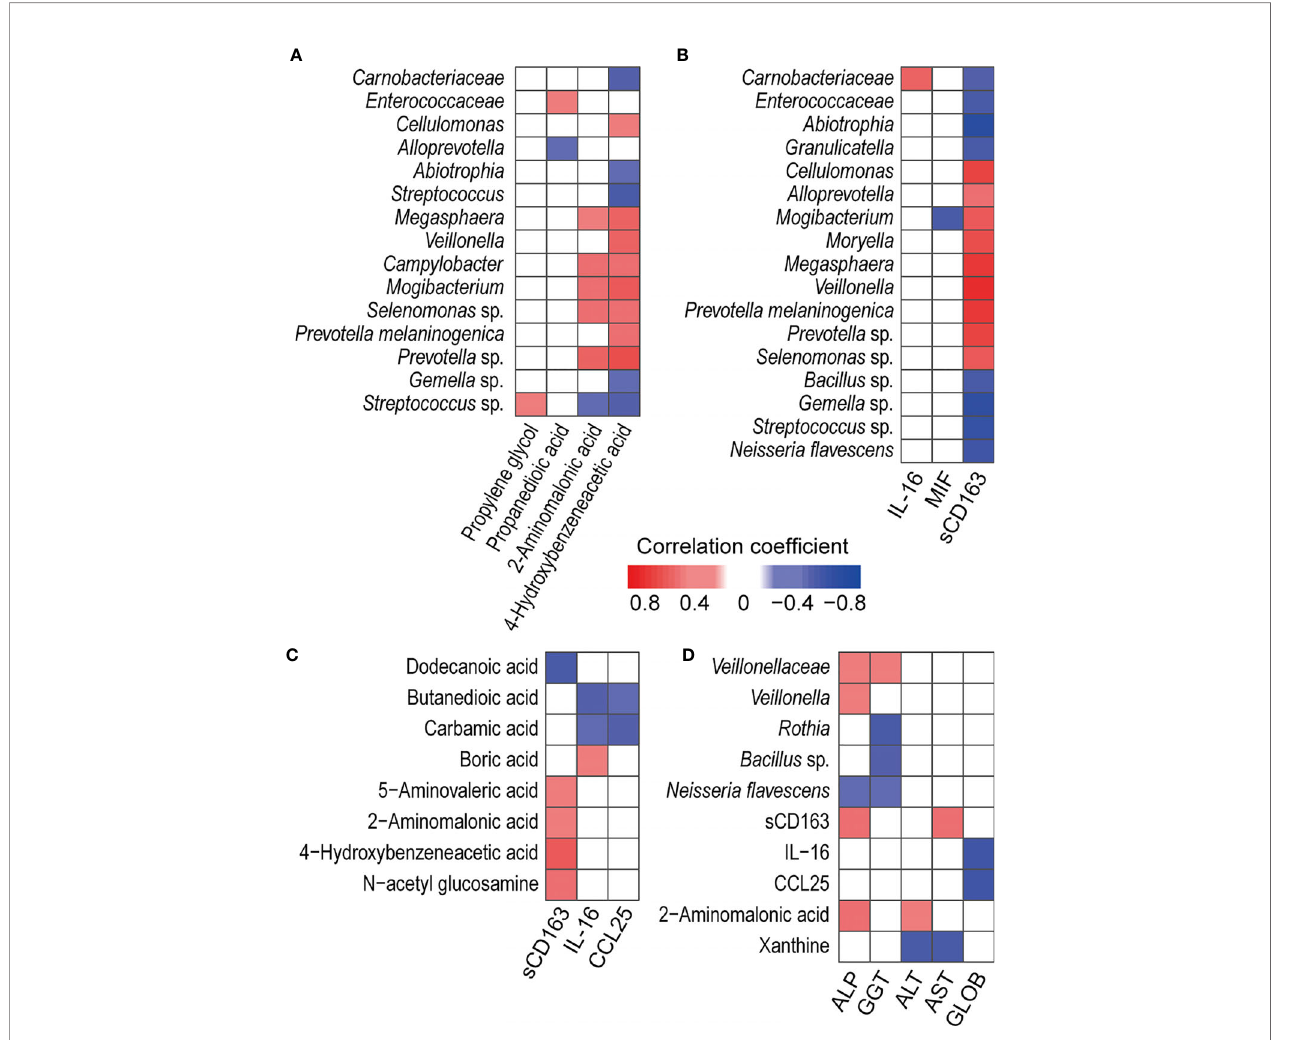
FIGURE 3 | Associations between PBC-altered salivary cytokines, metabolites, and bacteria and their associations with haematological variables or liver functions. (A) Association of PBC-altered salivary bacteria with metabolites. (B) Association of PBC-altered salivary bacteria with cytokines. (C) Association of PBC-altered salivary metabolites with cytokines. (D) Association of PBC-altered salivary bacteria, cytokines and metabolites with haematological variables or liver functions. Both correlation coef fi cients (in absolute value) higher than 0.4 and P < 0.01 were used as signi fi cance